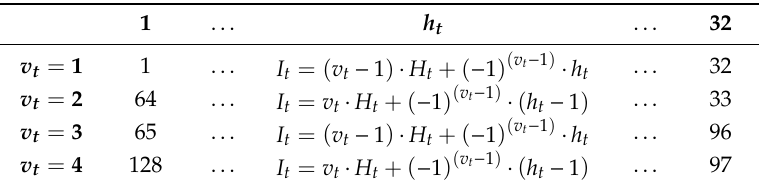
Table 1. Description of the beam